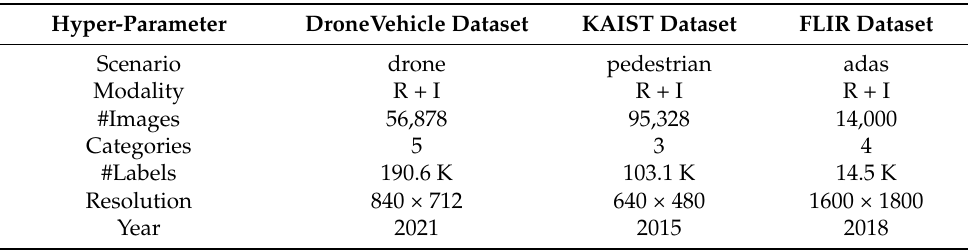
Table 1. Dataset information we used in this